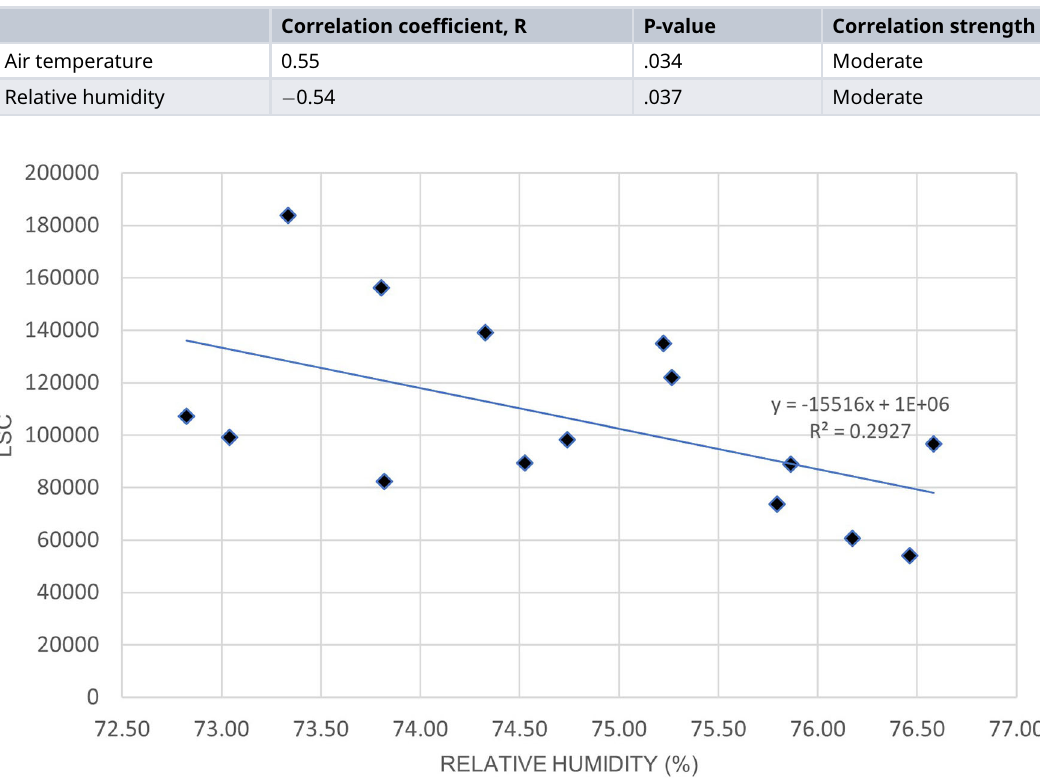
Figure 6. LSC vs relative humidity over Oceania during March to July